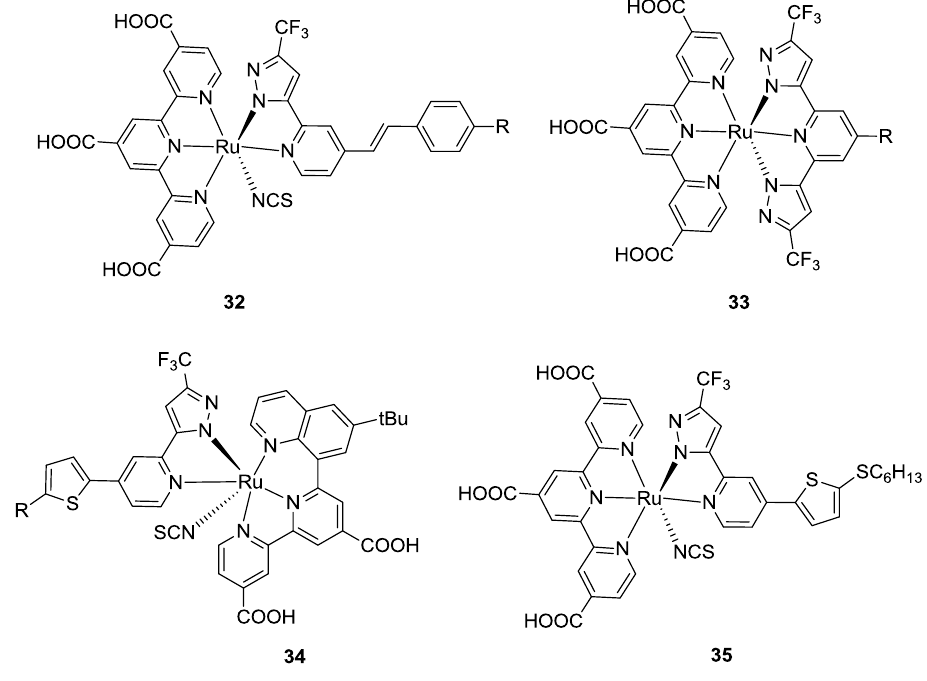
Figure 26. Pyridyl-pyrazolate ligand and quinolyl-bipyridine ligand for Ru(II)-complexes [22,127-129].